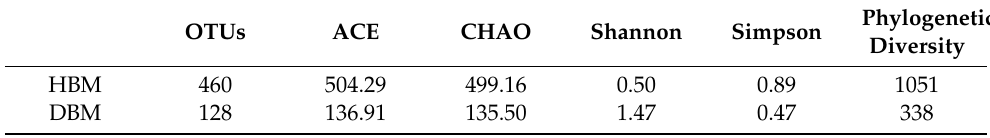
Table 1. α -diversity of Gochujang .